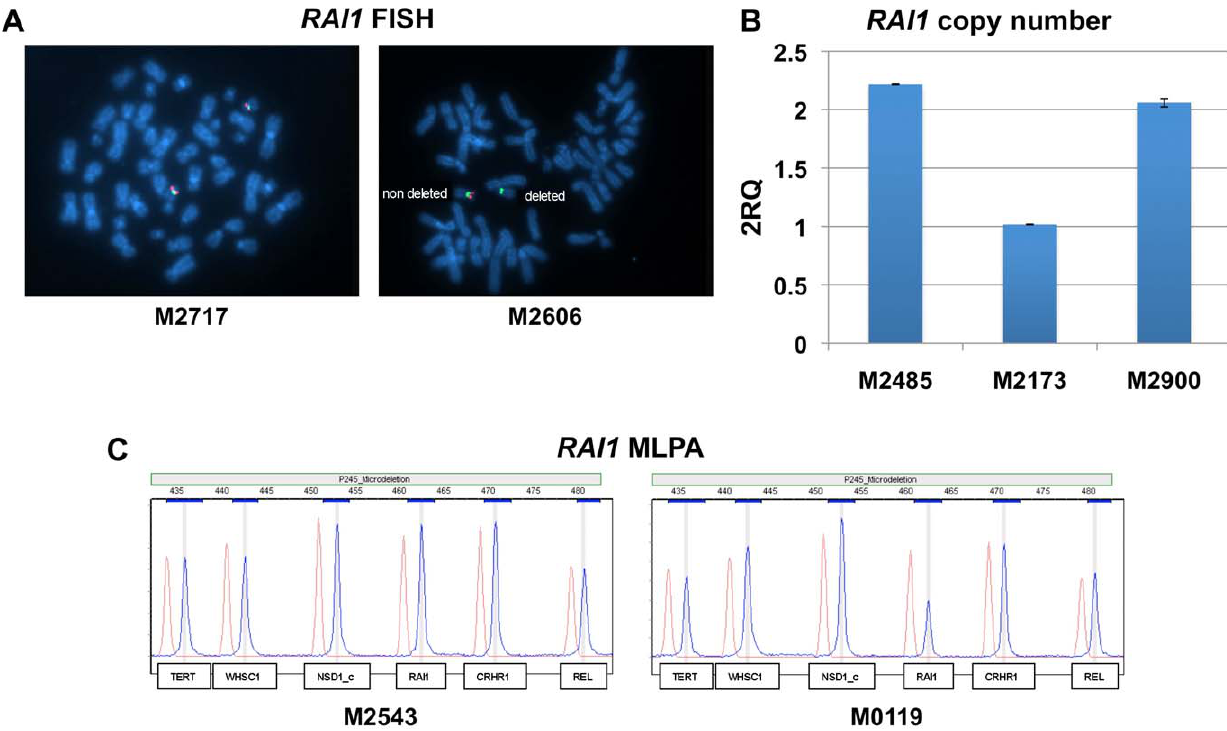
Figure 1. RAI1 copy number analysis. (A) Representative images of two-color FISH analysis on metaphase chromosomes of lymphoblastoid cells of an SMS patient without (M2717) and with (M2606) the 17p11.2 deletion. The probes were specific for the RAI1 locus (RP1–253P7; red) and for the chromosome 17 centromere (green). The chromosomes were counterstained with DAPI (blue). (B) Copy number analysis by qPCR using TaqMan primer-probe assays targeting exon 6 of RAI1 (Hs025670777_s1) and the endogenous control gene RNaseP . The comparative Ct method (RQ, relative quantification) was used to determine the RAI1 gene copy number as shown for a non-deleted patient (M2485), a 17p11.2 deleted patient (M2173) and a non-deleted patient with a familial RAI1 variant (M2900). (C) Results of MLPA copy number analysis, shown for 6 genes including RAI1 from the P245-A2 kit. Results are shown for an SMS patient without the 17p11.2 deletion (M2543) and a patient with 17p11.2 deletion (M0119).